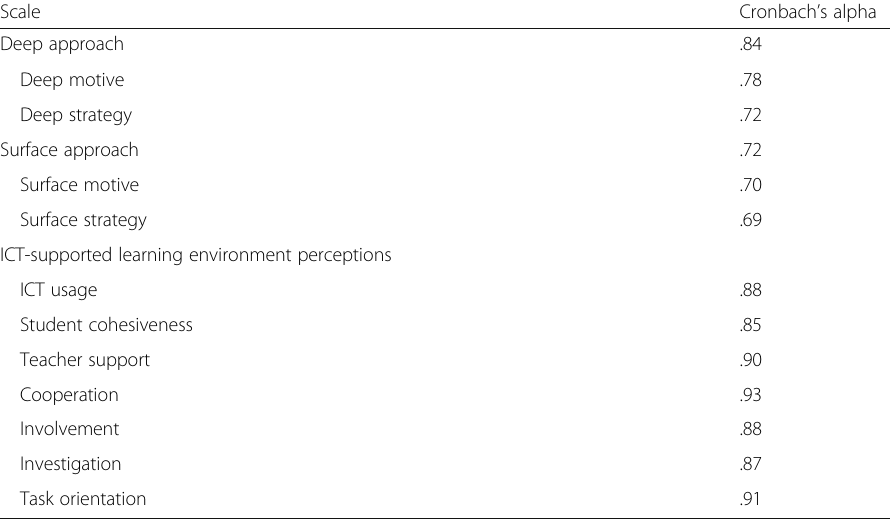
Table 3 Reliability of the instruments in pilot test ( N =